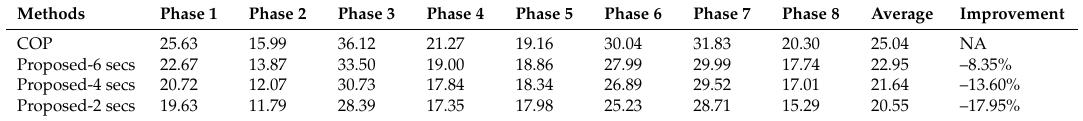
Table 4. The average vehicle delay of each phase (volume level is 2500